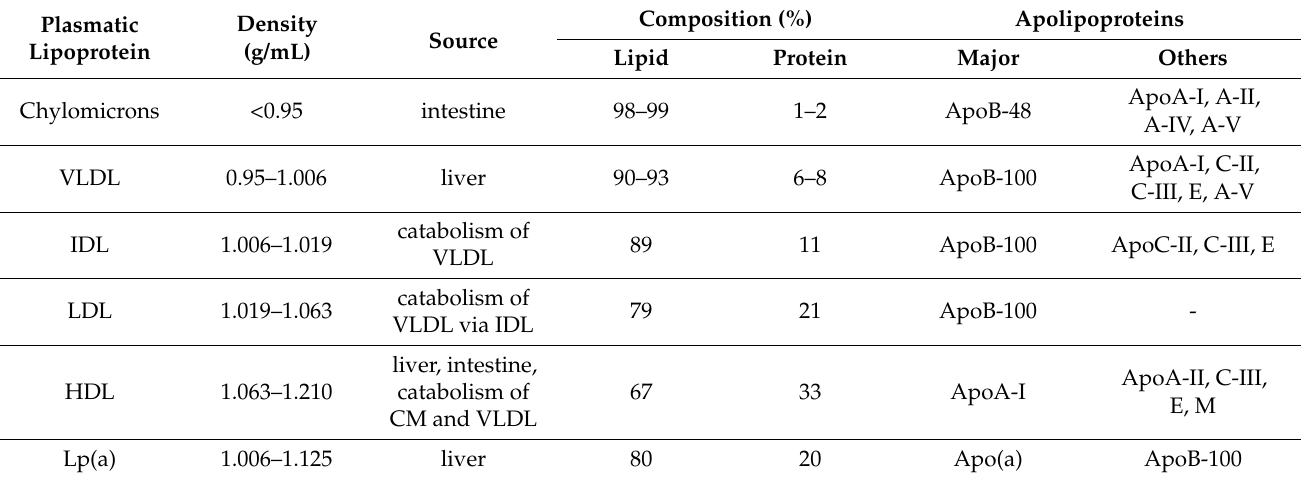
Table 1. Physical and chemical characteristics of human plasma